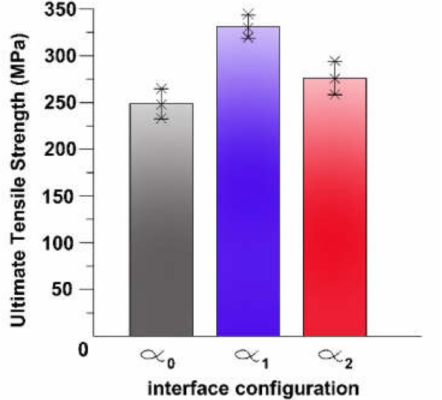
Figure 9. Ultimate tensile strength of the CDW joint.